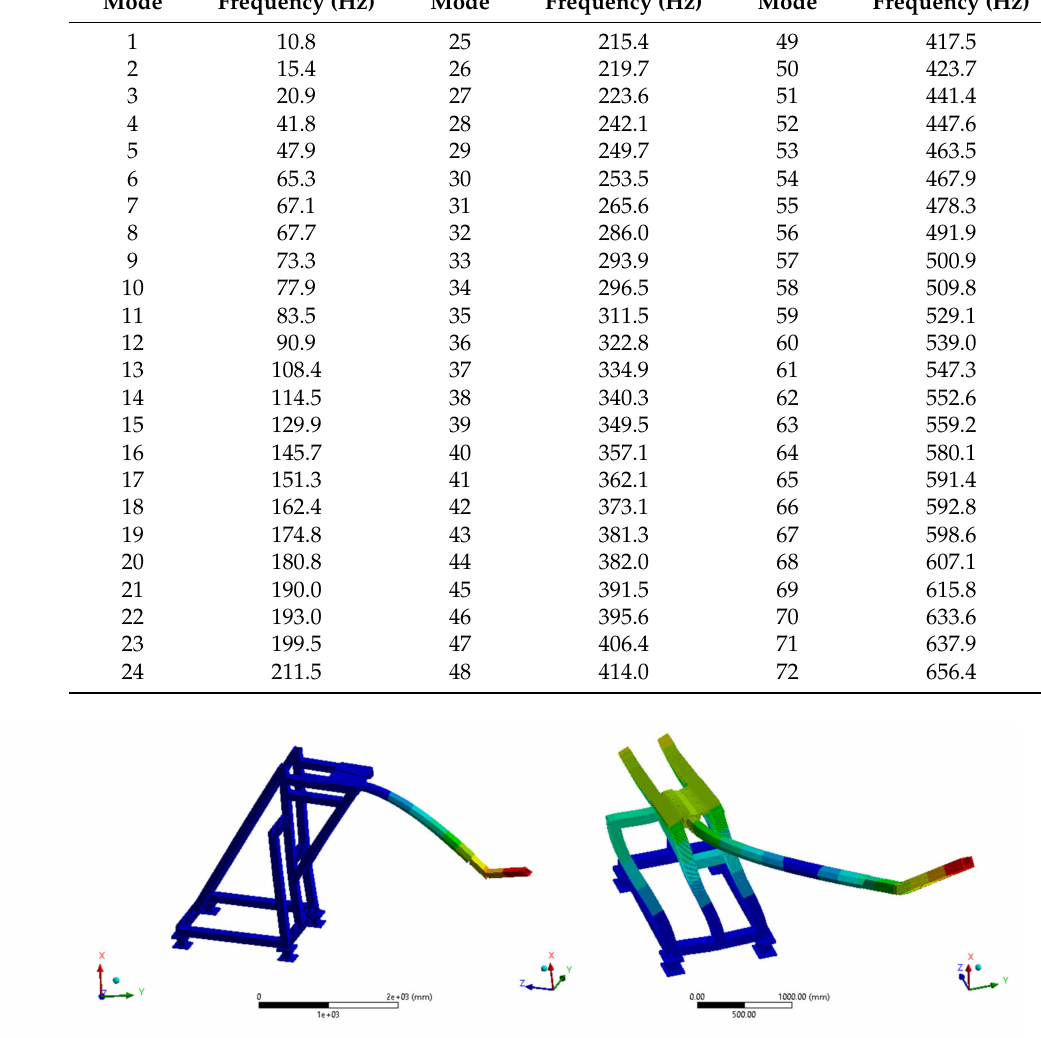
Table 1. Natural frequencies of the global structure.